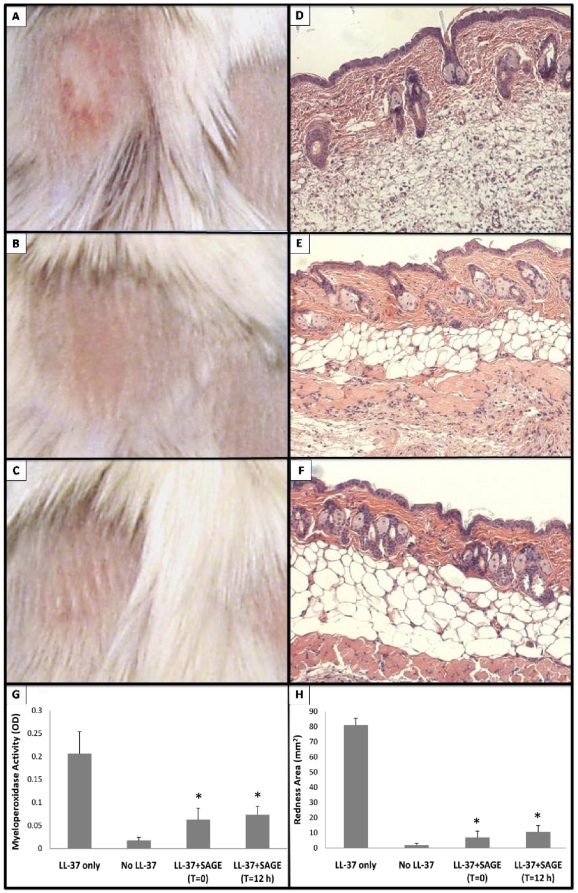
Topical SAGE reduces LL-37-induced inflammation.Balb/c mice were injected intradermally as described in Figure 5, and treated topically with GM-1111-1 (1% w/w) in a triglyceride-based emollient. A–C. Gross pictures of LL-37 injected skin region: A, no treatment; B, GM-1111 treatment immediately (t = 0) after LL-37 injection; C, GM-1111 treatment beginning at t = 12 h after LL-37 injection. D. H&E-stained cross-sectional view of a LL-37 injected skin sample. E. H&E-stained cross-sectional view of GM-1111 treatment at t = 0 in LL-37 injected skin region. F. H&E-stained cross-sectional view of GM-1111 at t = 12 h treatment in LL-37 injected skin region. G. MPO activity measurement of LL-37 injection with different treatments. H. Area of erythema from LL-37 injection. *P<0.05 vs intradermal LL-37 alone; n = 6 per group.